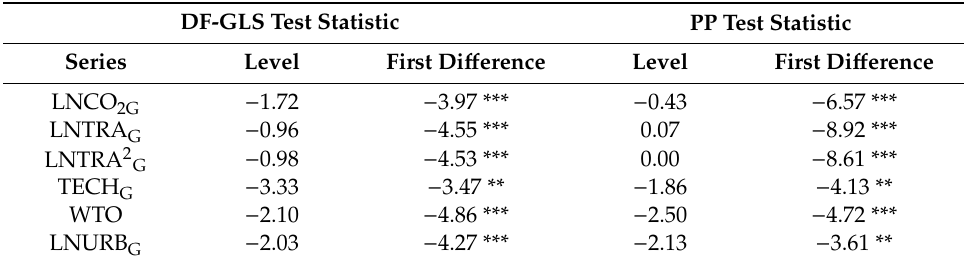
Table 8. Unit root tests results for Model 2—Bilateral trade from Germany to China.